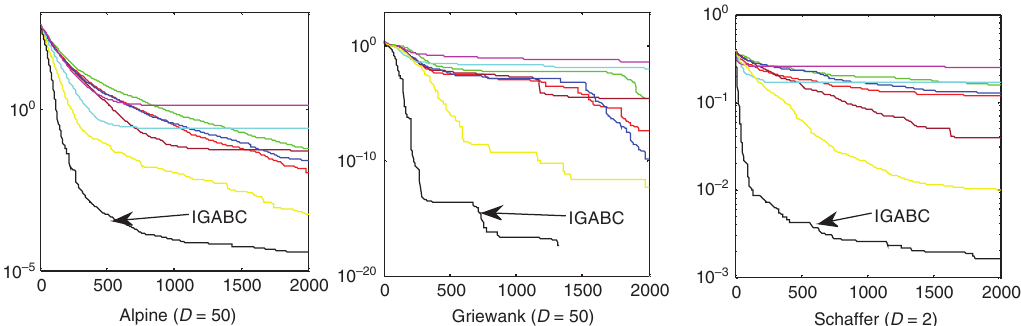
Figure 3: The Convergent Curve of Different Benchmark Functions.